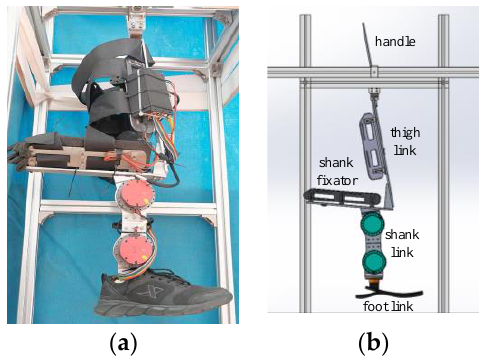
Figure 6. ( a ) Lower-limb prosthesis designed for healthy subjects. ( b ) Mechanical structure diagram of lower-limb prosthesis.